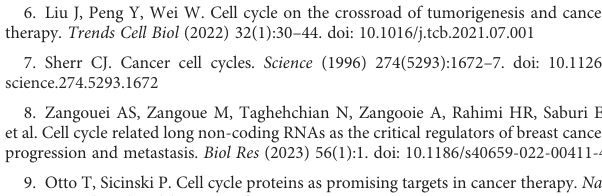
SUPPLEMENTARY FIGURE 1 Venn diagram highlighting the shared differentially expressed cell cycle- related genes in both LUAD and LUSC cohorts. SUPPLEMENTARY FIGURE 2 mRNA expression levels of ZWINT in different types of cancers (A) ZWINT expression traits in cancerous and normal samples based on the TCGA cohort. (B) ZWINT expression traits in cancerous and normal samples based on the TCGA and GTEx cohorts. SUPPLEMENTARY FIGURE 3 Prognostic signi fi cance of ZWINT gene in pan cancer by univariate COX regression analysis. SUPPLEMENTARY FIGURE 4 Overall survival of the ZWINT gene in pan cancer by KM analysis. SUPPLEMENTARY FIGURE 5 Progression-free interval of ZWINT gene in pan cancer by KM analysis. SUPPLEMENTARY FIGURE 6 Disease-speci fi c survival of ZWINT gene in pan cancer by KM analysis. SUPPLEMENTARY FIGURE 7 Disease-free interval of ZWINT gene in pan cancer by KM analysis. SUPPLEMENTARY FIGURE 8 RelationshipbetweentheexpressionlevelsofZWINTandimmunecheckpoints. SUPPLEMENTARY FIGURE 9 Relationship between ZWINT and immunotherapy.